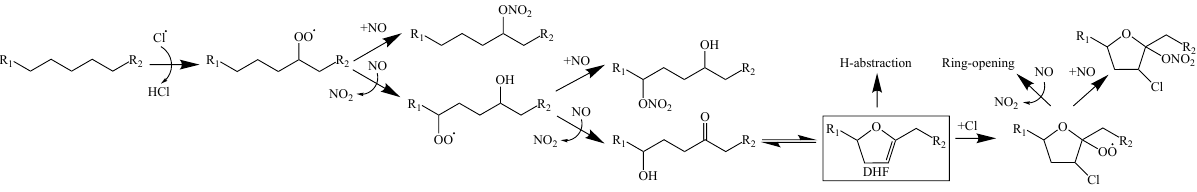
Figure 2. Formation pathway of chlorinated organics via chlorine addition to the DHF. H abstraction from DHF is also possible. Ozone may also react with the double-bond on the DHF, competing with chlorine radicals. Reaction pathways leading to DHF are adapted from OH-initiated oxidation of alkanes (Lim and Ziemann,